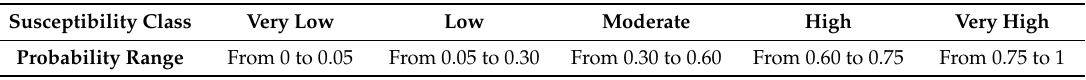
Table 6. The probability intervals for the landslide susceptibility